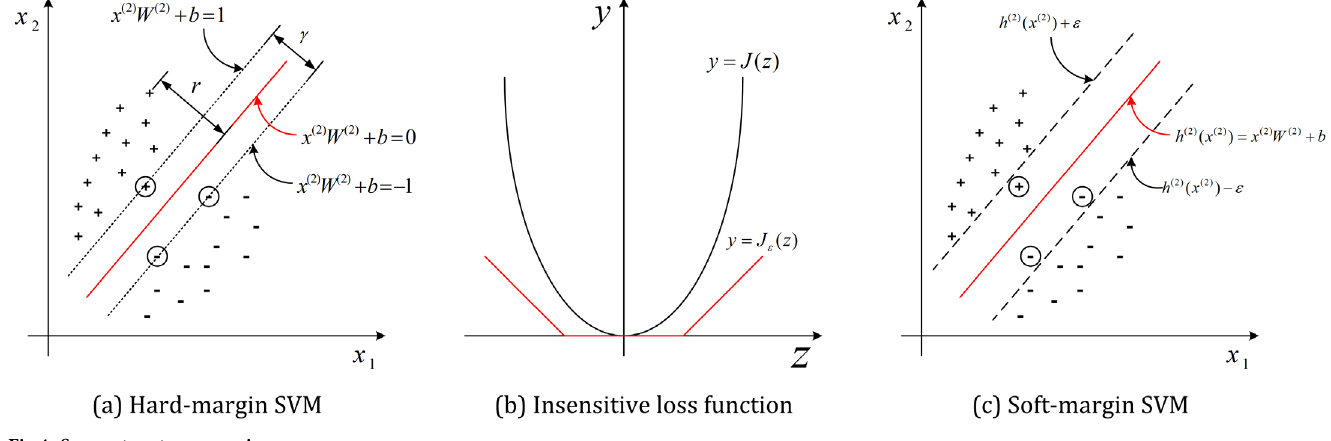
Fig 4. Support vector